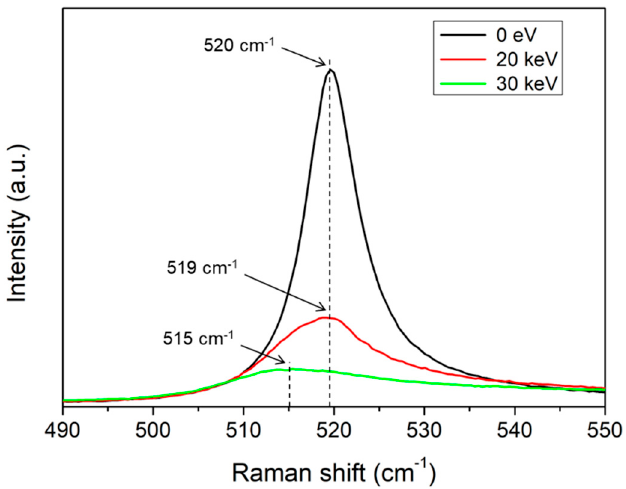
Figure 2. Raman spectrum waveband (490 cm − 1 –550 cm − 1 ) after irradiating electron beams with acceleration voltages of 0 eV, 20 keV, and 30 keV around the aperture hole of a Si electron lens fabricated using the MEMS process for 24 h.